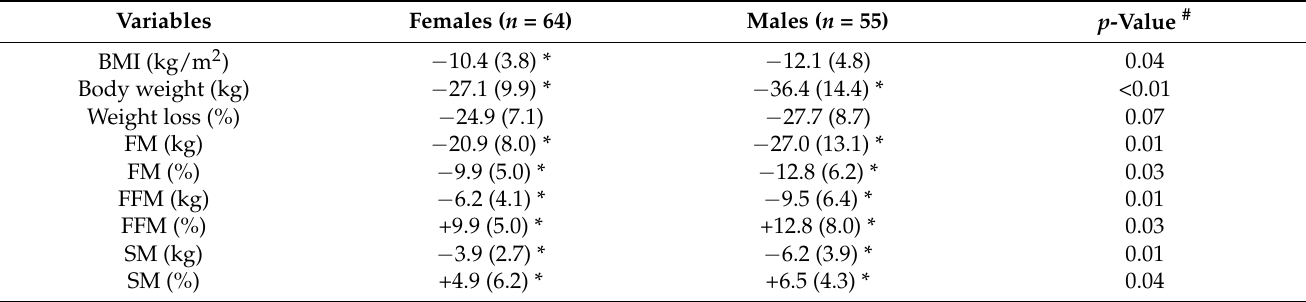
Table 2. Body composition changes at 12 months after LSG according to